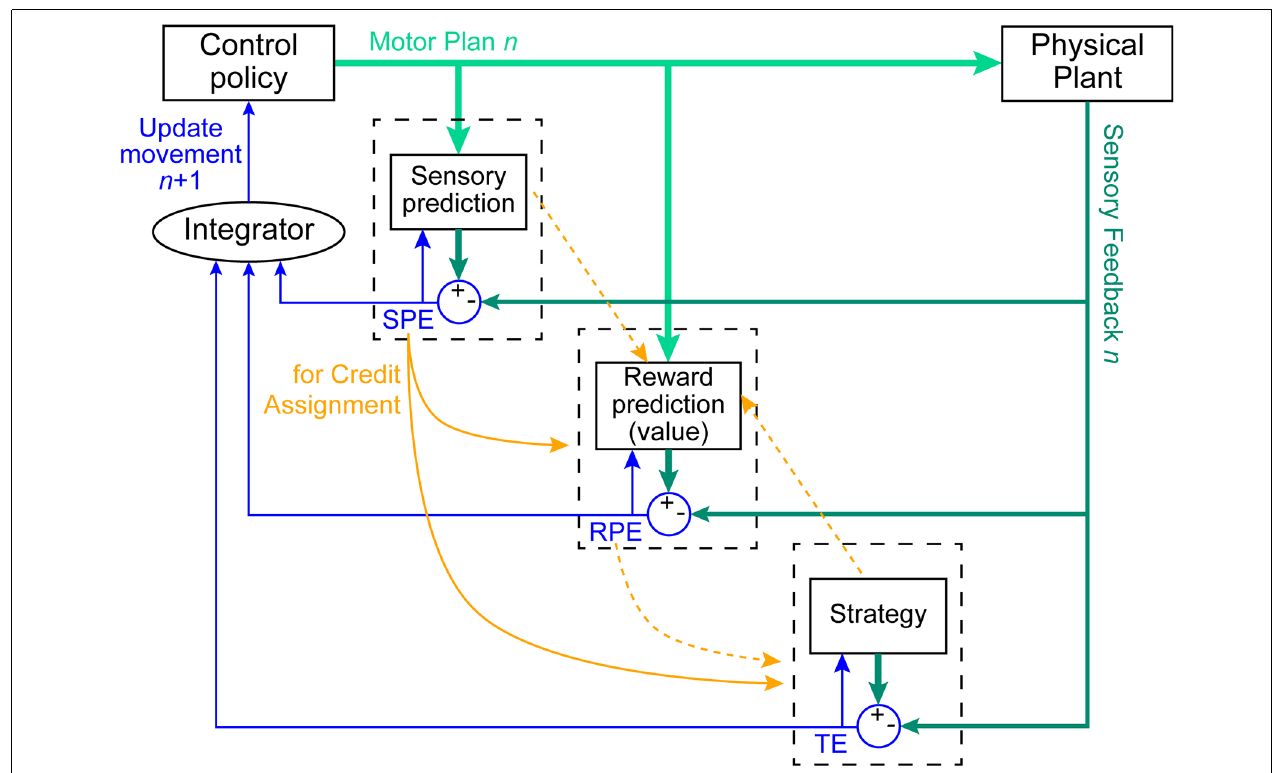
FIGURE 1 | Control policy updates arising from the interactions of three learning mechanisms. On trial n , a control policy is issued to perform the current movement (light green thick arrows). This plan is executed by the body (physical plant), and sensory feedback is detected (dark green arrows). The SPE-driven learning system predicts the expected sensory consequences of the movement, which is compared against sensory feedback of the actual executed movement to compute a sensory prediction error (SPE). The reinforcement learning system predicts the expected reward associated with that movement and this is compared against the actual reward outcome to compute a reward prediction error (RPE). The explicit learning system compares the expected outcome of the strategy against the observed movement outcome to compute a task error (TE). In all cases, the computed error signals (thin blue arrows) update both the respective prediction mechanism as well as the control policy for the next ( n + 1) movement. Most studies treat this control-policy update as the combination of the contributions of the individual learning systems (here labeled as the Integrator). We suggest that these systems also interact in other ways. For example, SPE signals are a means by which the reinforcement-learning and explicit-learning systems could solve the credit-assignment problem in determining whether the policy or the execution of that policy led to the observed result (solid orange arrows). Additional speculated interactions may exist (dashed orange arrows), although more behavioral evidence is needed to support the existence of such connections in